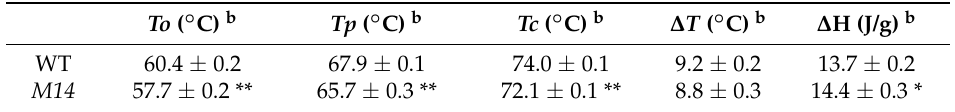
Table 1 Thermal properties of starches a . Table 1. Thermal properties of starches a